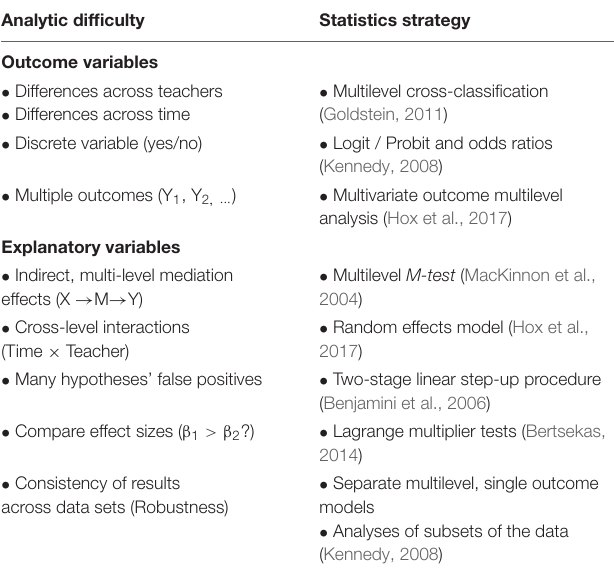
TABLE 2 | Statistics strategies to address each analytic